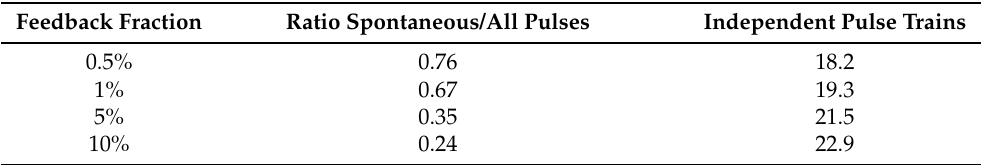
Table 1. Percentage of spontaneous and stimulated pulses within total pulses